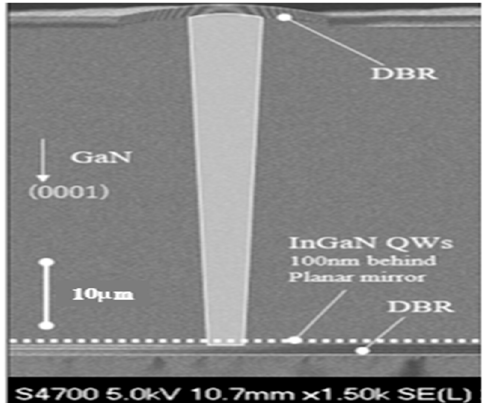
Figure 3. The cross-sectional SEM image of GaN-based VCSELs with curved mirrors